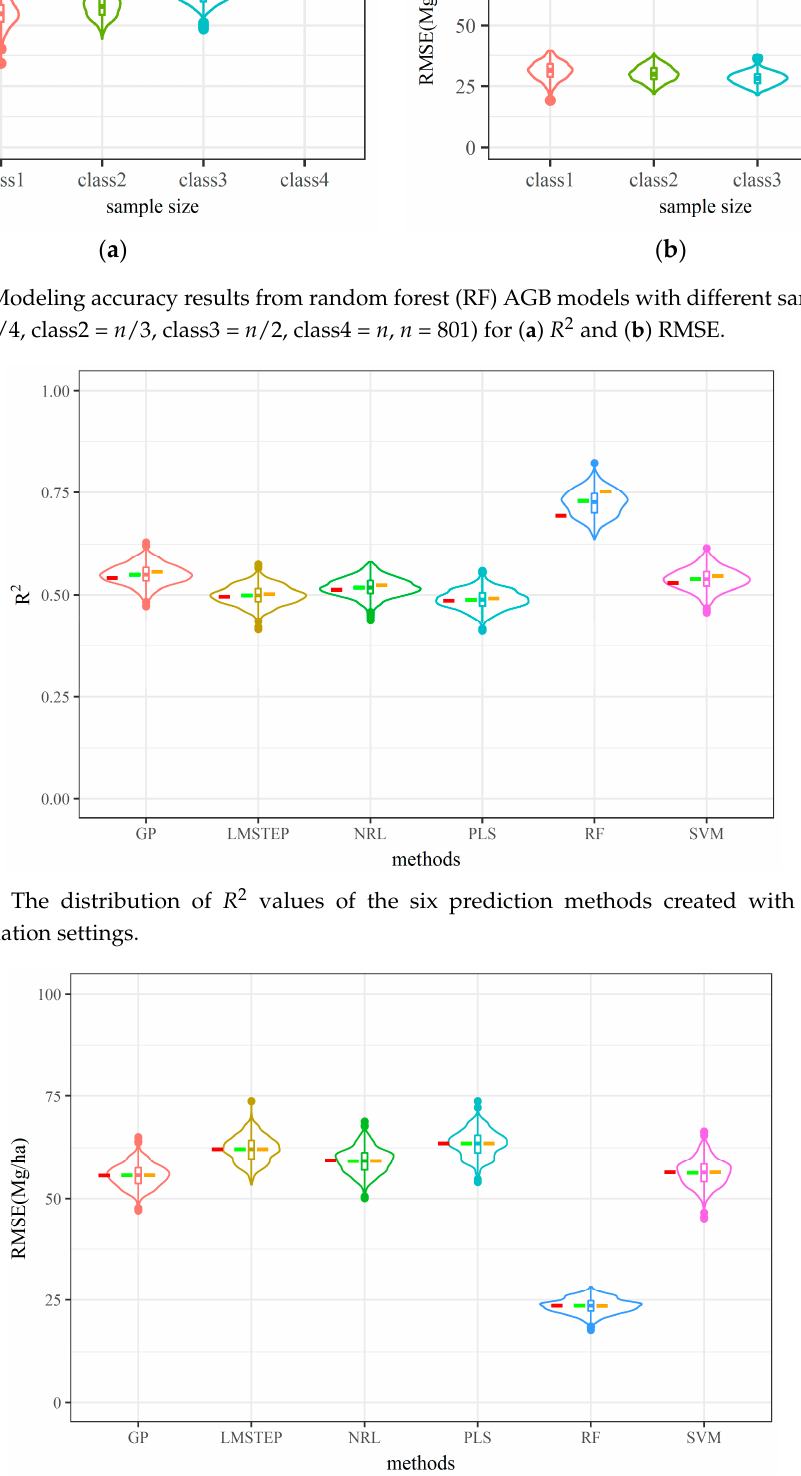
Figure 6. Modeling accuracy results from random forest (RF) AGB models with different sample size (class1 = n /4, class2 = n /3, class3 = n /2, class4 = n , n = 801) for ( a ) R 2 and ( b ) RMSE.